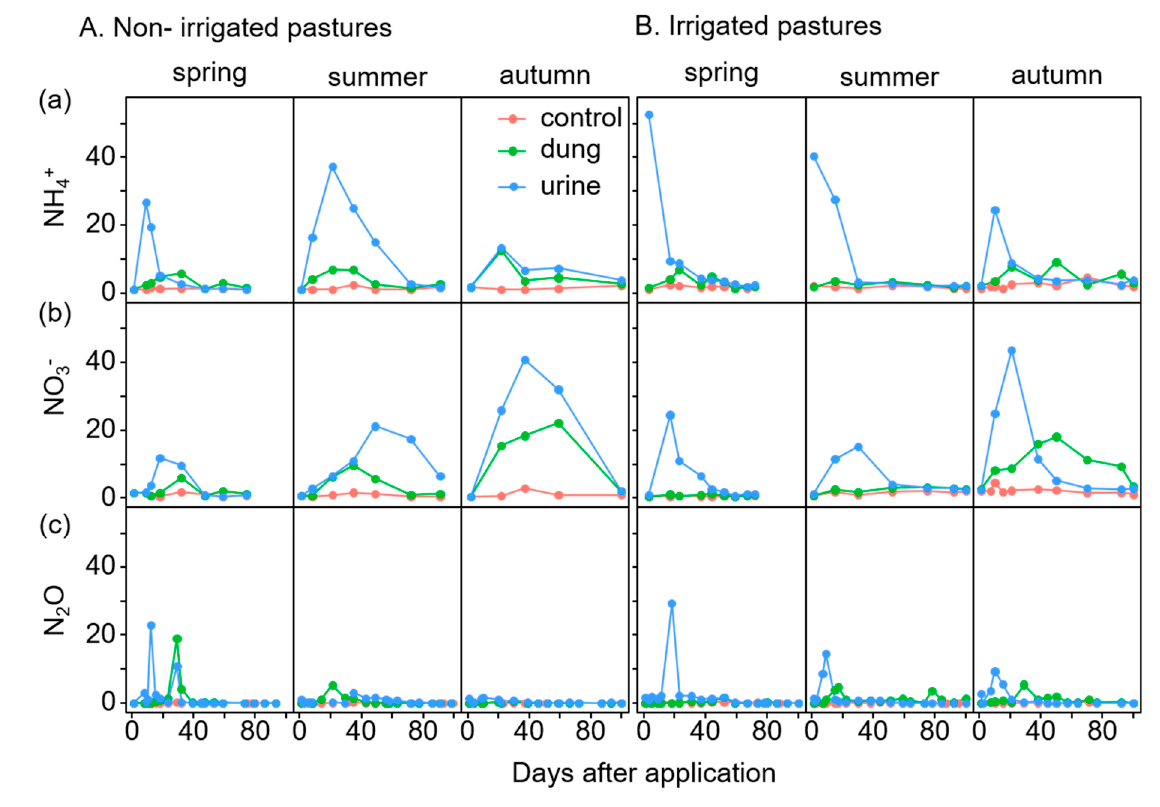
Figure 4. Changes in the soil ( a ) ammonium (mg N kg − 1 dry soil), and ( b ) nitrate contents (mg N kg − 1 dry soil) plus daily emissions of ( c ) nitrous oxide (mg N m − 2 d − 1 ) from ( A ) non-irrigated pastures pooled across grasslands and ( B ) irrigated pastures.